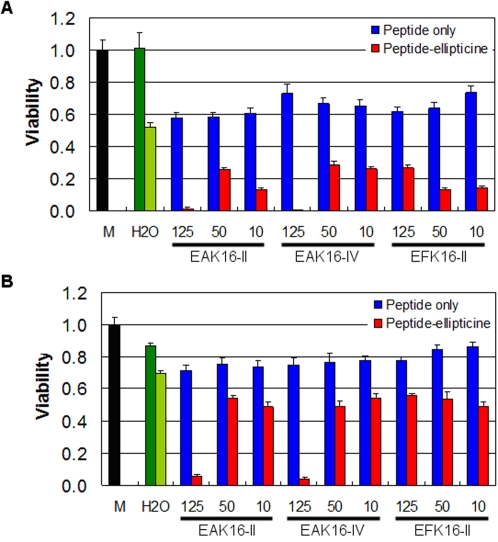
Cellular toxicity of the peptides and their complexes with ellipticine for A549 cells (a) and MCF-7 cells (b).The viability of non-treated cells is 1 (M: cells were treated with culture medium). For the solvent control, cells were treated with pure water (dark green bar); for the drug control, cells were treated with ellipticine in pure water with the absence of peptides (light green bar). Blue bars represent the peptide controls where no ellipticine was added.